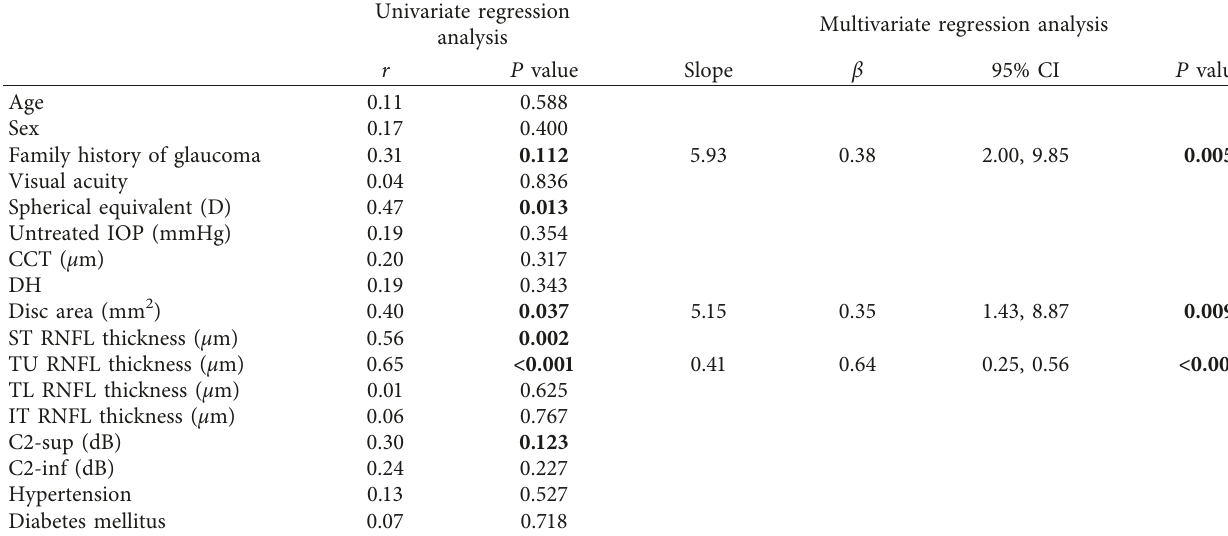
Table 4: Univariate and multivariate regression analyses for superior mGCC thickness in the inferior visual field defect